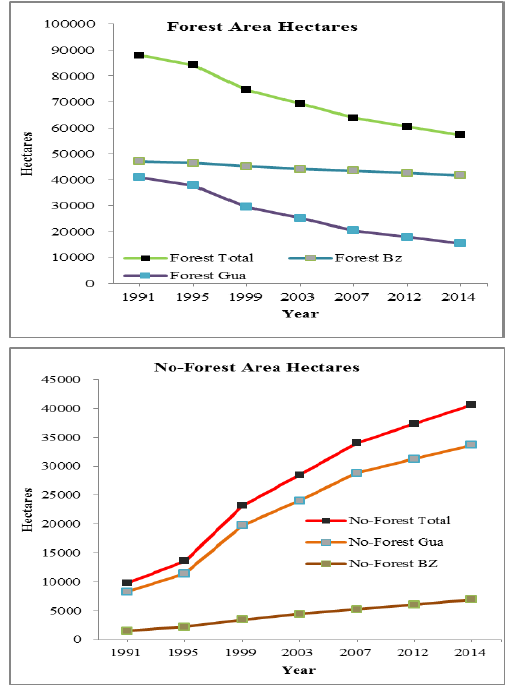
Figure 4. Study site forest cover and forest loss